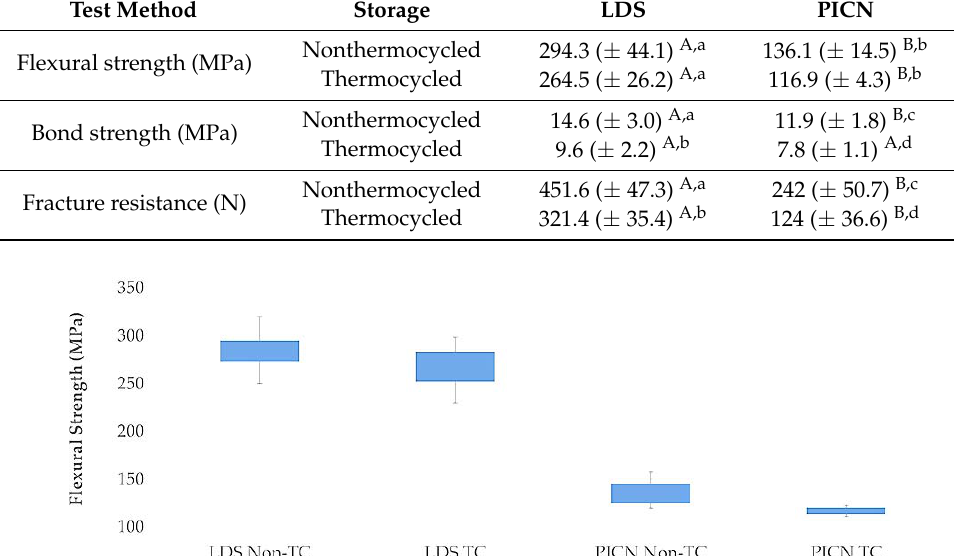
Figure 3. Box plot of flexural strength for each group.